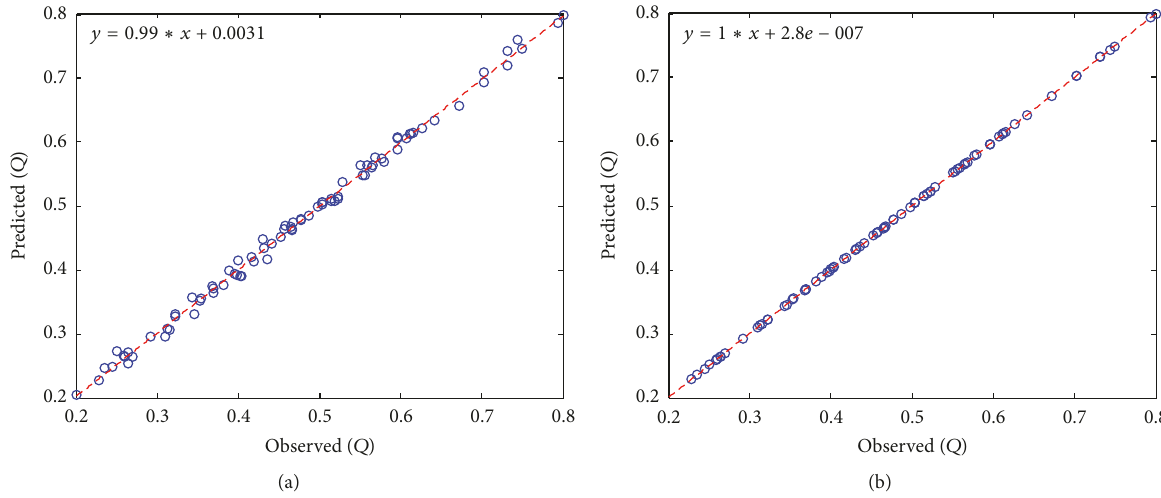
Figure 6: Training performance of the designed models (a) NHW and (b) DANFIS.